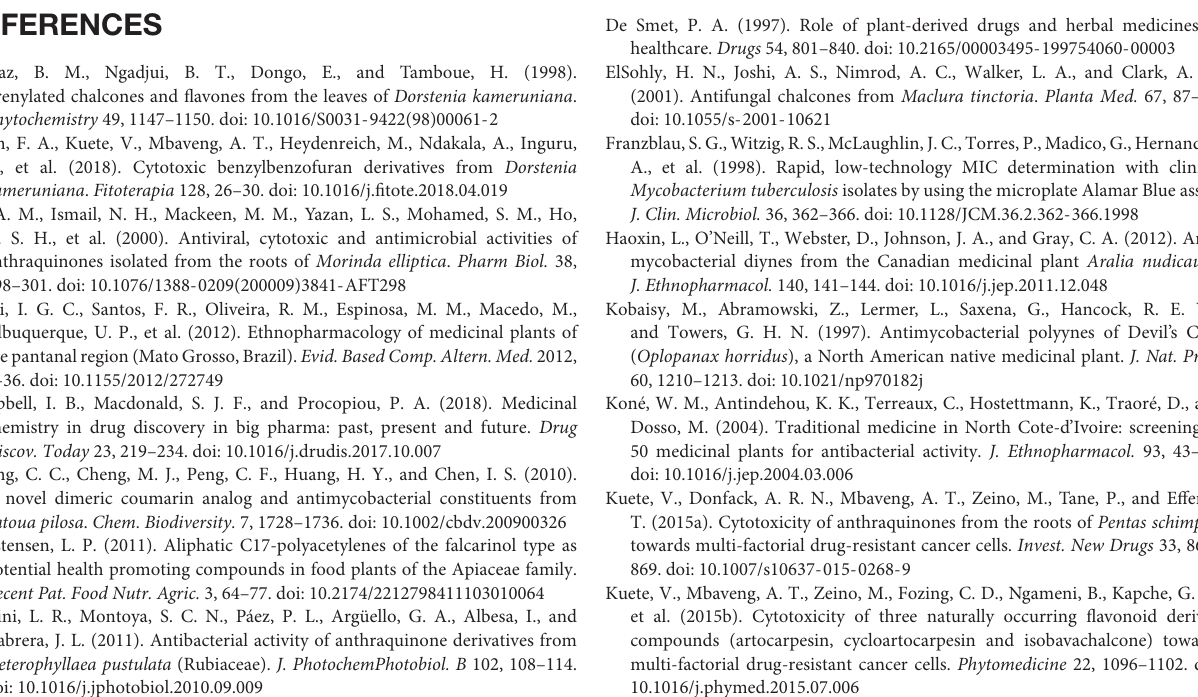
Supplementary Figure 1 | Dose response curves of M. tuberculosis treated with isoniazid or linezolid. M. tuberculosis was treated for 7 days with drug concentrations ranging from 200 µ g/mL to 0.09 µ g/mL, in three-fold serial dilutions. Bacterial survival was measured after overnight incubation with CellTiter-Blue to establish minimum inhibitory concentrations (MICs). Data points are expressed as mean % survival relative to drug-free controls from duplicate biological replicates. Error bars represent the standard